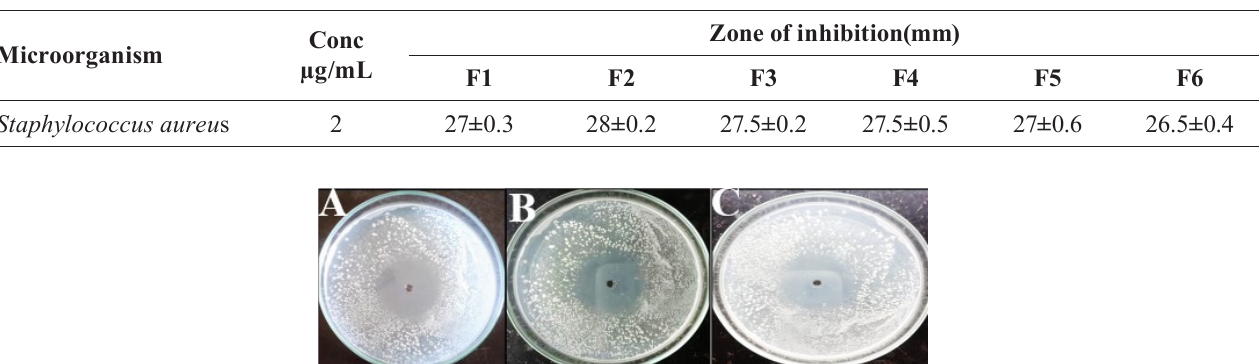
TABLE V - A ntimicrobial activity test